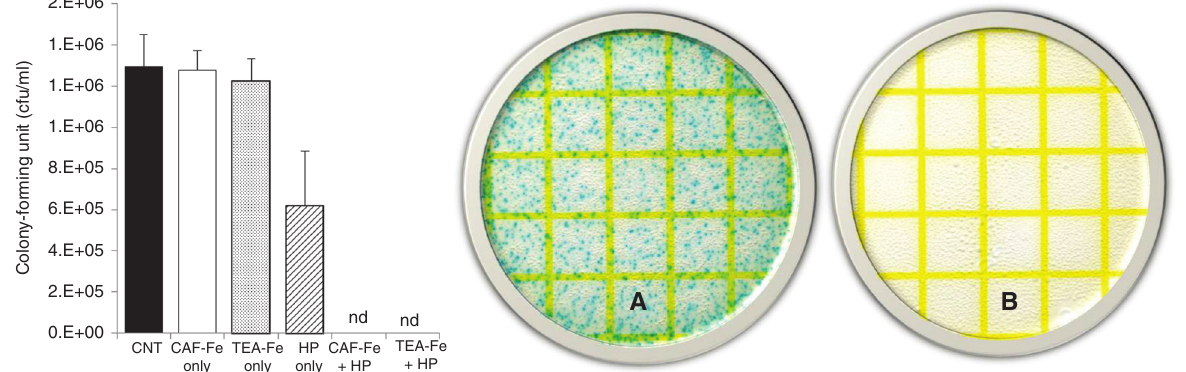
Figure 7 Effect of 10 mm hydrogen peroxide (HP) and TEA-Fe (1 mm Fe) and CAF-Fe (1 mm Fe) with 10 mm HP on disinfection of Escherichia coli ATCC11229. The picture shows 3 M Petrifilms of (A) 10 mm HP and (B) 10 mm of HP with the ‘green’ TEA-Fe catalyst treatments, respec- tively. E.coli coliforms are blue colonies. nd means not